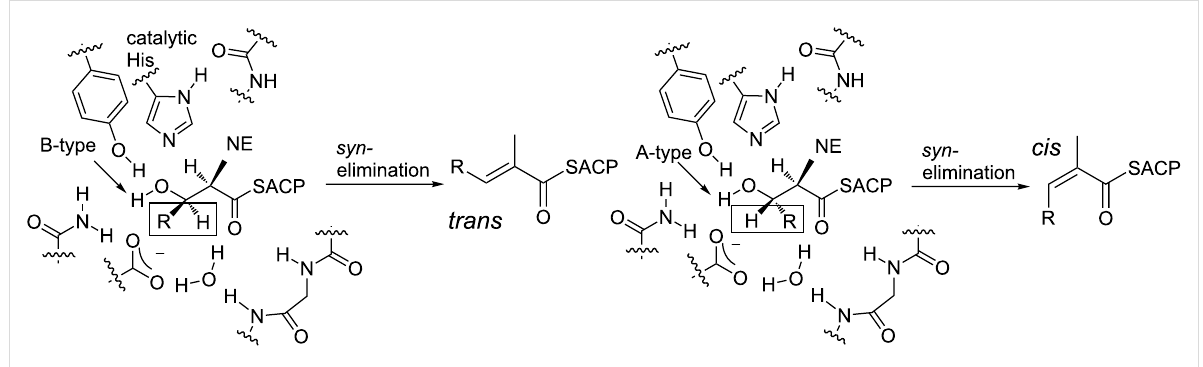
Figure 15: Model for DH-catalyzed generation of trans and cis double bonds by syn elimination from substrates bearing C-2-methyl groups (the side chains shown are those found in DEBS DH 4 [92]). Both substrates incorporate a (2 R )- (non-epimerized, NE) methyl group, but differ in the relative ori- entation of the C-3 H and R groups within the active site (boxed). In both cases, however, the hydroxy group is held in place by interactions with Tyr and Asp residues. Syn dehydration of the product derived from B-type reduction (indicated) directly yields a trans double bond, while syn dehydration of an A-type hydroxy substrate directly gives a cis double bond. Adapted from